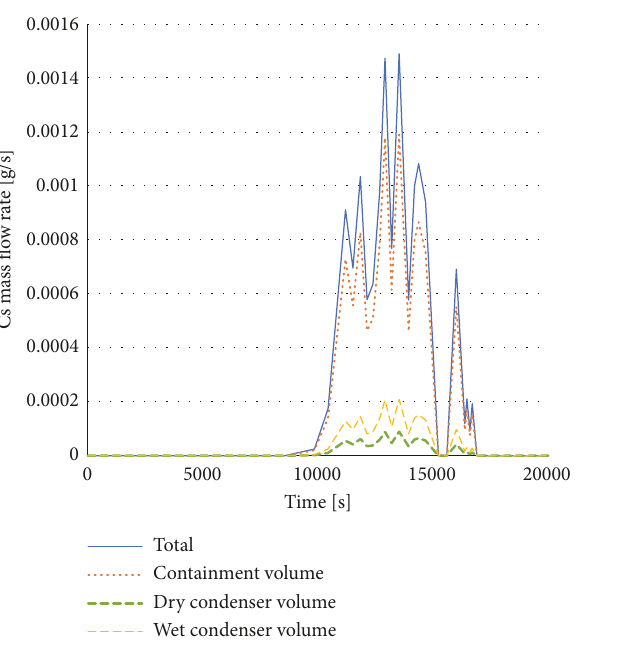
Figure 10: CsOH mass flow rates of containment volume, dry condenser volume, and wet condenser volume in ART Mod 2.